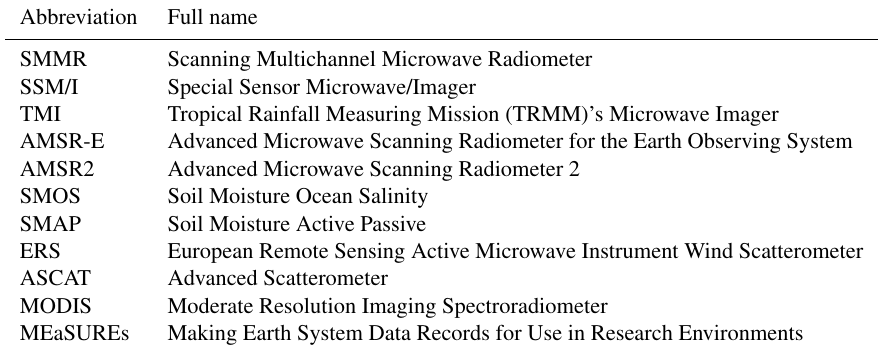
Table 1. Abbreviations for the name of satellites, remote sensors, and